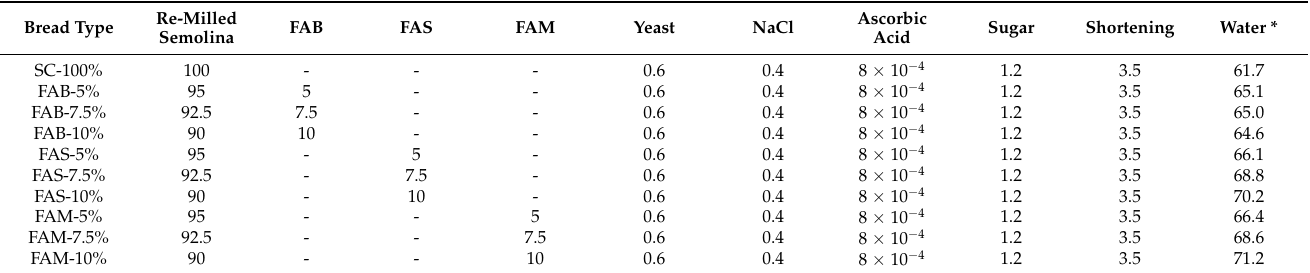
Table 8. Formulation of the experimental breads (g for 100 g of re-milled